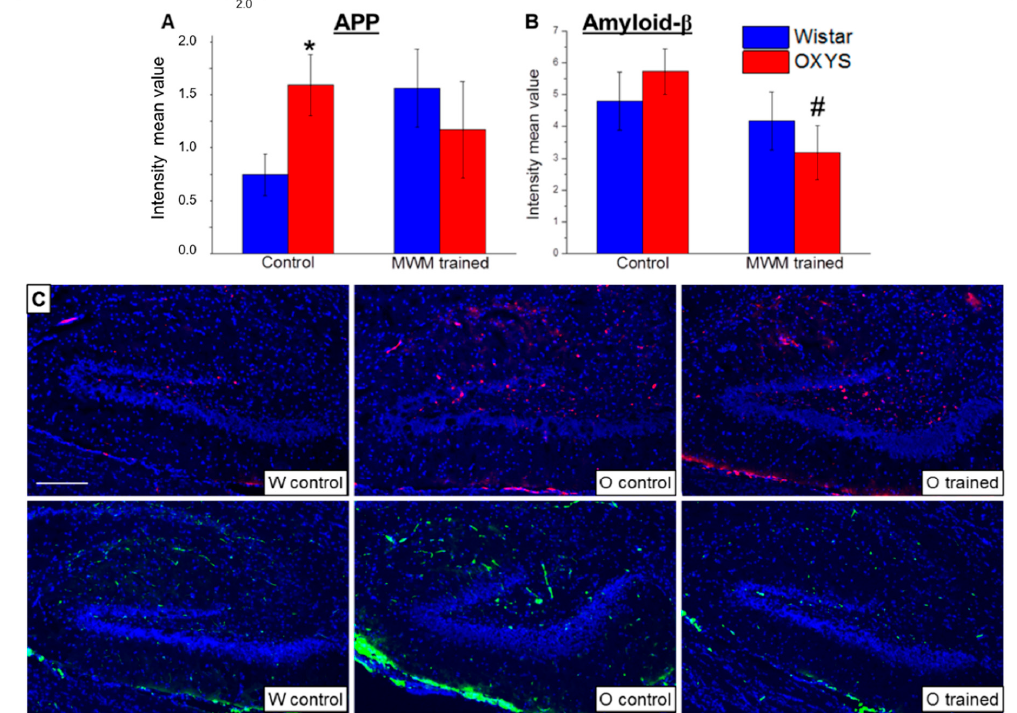
Figure 5. Mean immunofluorescence intensity of APP and amyloid- β in the DG of OXYS and Wistar rats at age 13 months. The load of APP ( A ) was higher in OXYS rats than in Wistar rats. MWM training did not a ff ect APP content but decreased levels of amyloid- β ( B ) in OXYS rats. The data are presented as mean ± SEM, n = 6. * p < 0.05 for di ff erences between the strains; # p < 0.05 for e ff ects of the MWM training. W: Wistar rats; O: OXYS rats. ( C ) Photomicrographs of the DG of untrained Wistar and OXYS rats and a trained OXYS rat are shown as representative images of immunohistochemical staining with antibodies against APP (red) and amyloid- β (green). DAPI (blue) highlights cell nuclei. The scale bar ( C ) is 200 µ